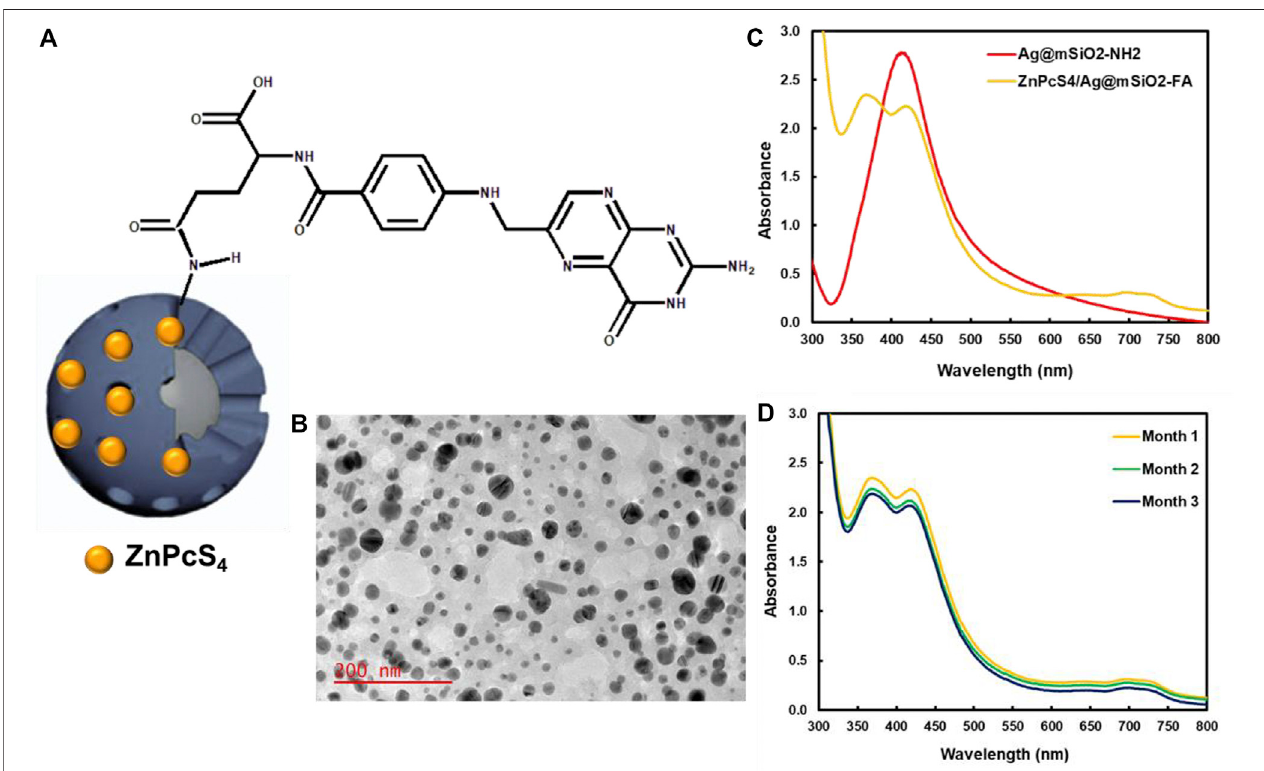
FIGURE2|(A) Schematicillustrationofamidebondsbetweenthecarboxyl groupsofFAandaminogroupsoftheZnPcS 4 /Ag@mSiO 2 -NH 2 NC, (B) TEMimageof ZnPcS 4 /Ag@mSiO 2 -FA, (C) UV-Vis spectra of ZnPcS 4 /Ag@mSiO 2 and ZnPcS 4 /Ag@mSiO 2 -FA NCs, and (D) stability of ZnPcS 4 /Ag@mSiO 2 -FA NC over 3